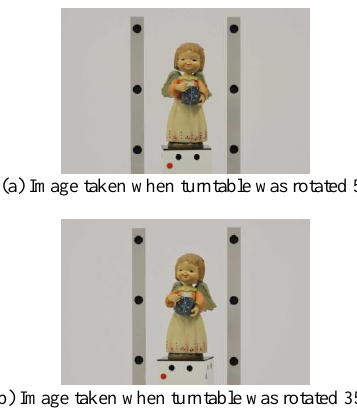
(b) Image taken when turntable was rotated 350° Figure 13. Images searched.